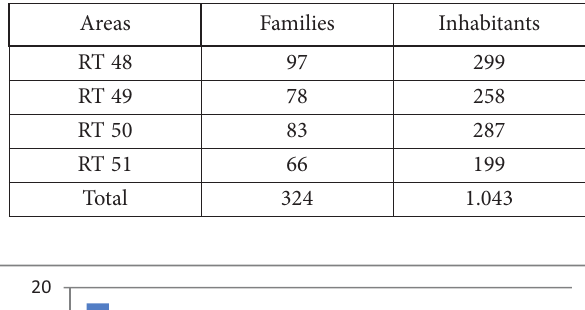
Table 3. Number of population in Kampong Pakuncen